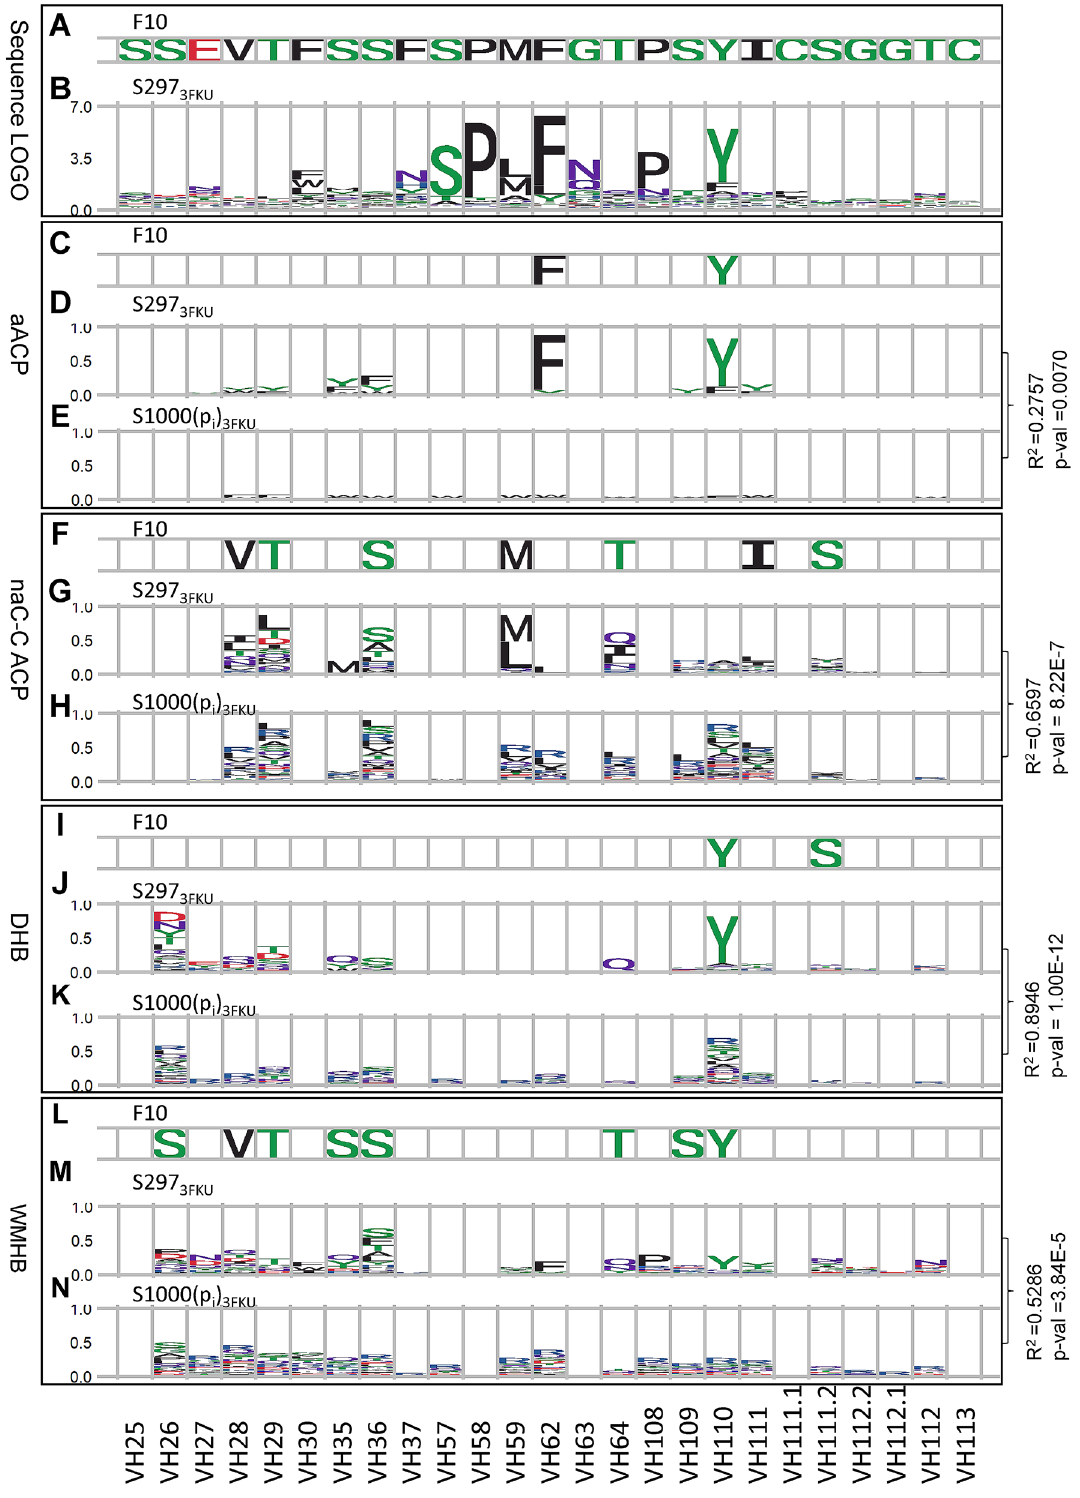
Figure 3. CDR sequence preferences for the interface residues in F10-HA complex structure (PDB code:3FKU). Complex structures of the 381 CDR sequence variants shown in Supplementary Tables S2–S4 in Tung et al. 62 were modelled with default Fold-X 59 based on the F10-HA complex structure in PDB code: 3FKU 61 . These computational structures form the dataset S381 3FKU as the positive control group for HA binding. The amino acid type distribution probabilities for the degenerate codon NNK (p i of Eq. (3) in Supplemental Methods) were applied to generate 1000 CDR sequence variants for the computational complex structures built with Fold-X. These computational structures form the dataset S1000(p i ) 3FKU as the null hypothesis control group for HA binding. The panels ( A – N ) were calculated as described in Fig. 2 with S381 3FKU S1000(p i ) 3FKU